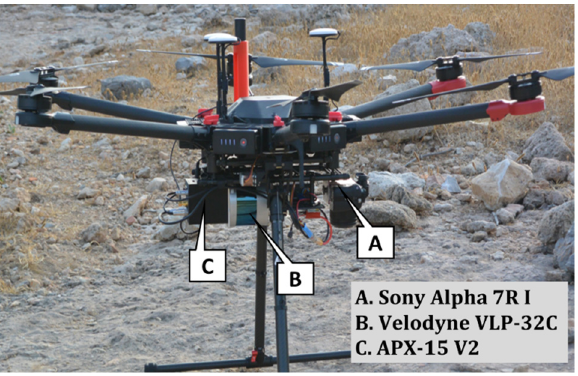
Figure 2. Illustration of the UAV-based MMS used in this study.